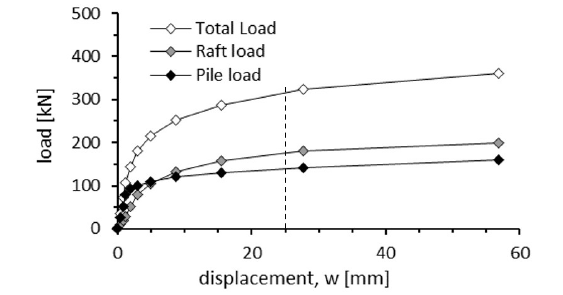
Figure 12. Load-settlement curves for case 8 - L=4m; t=0.1m